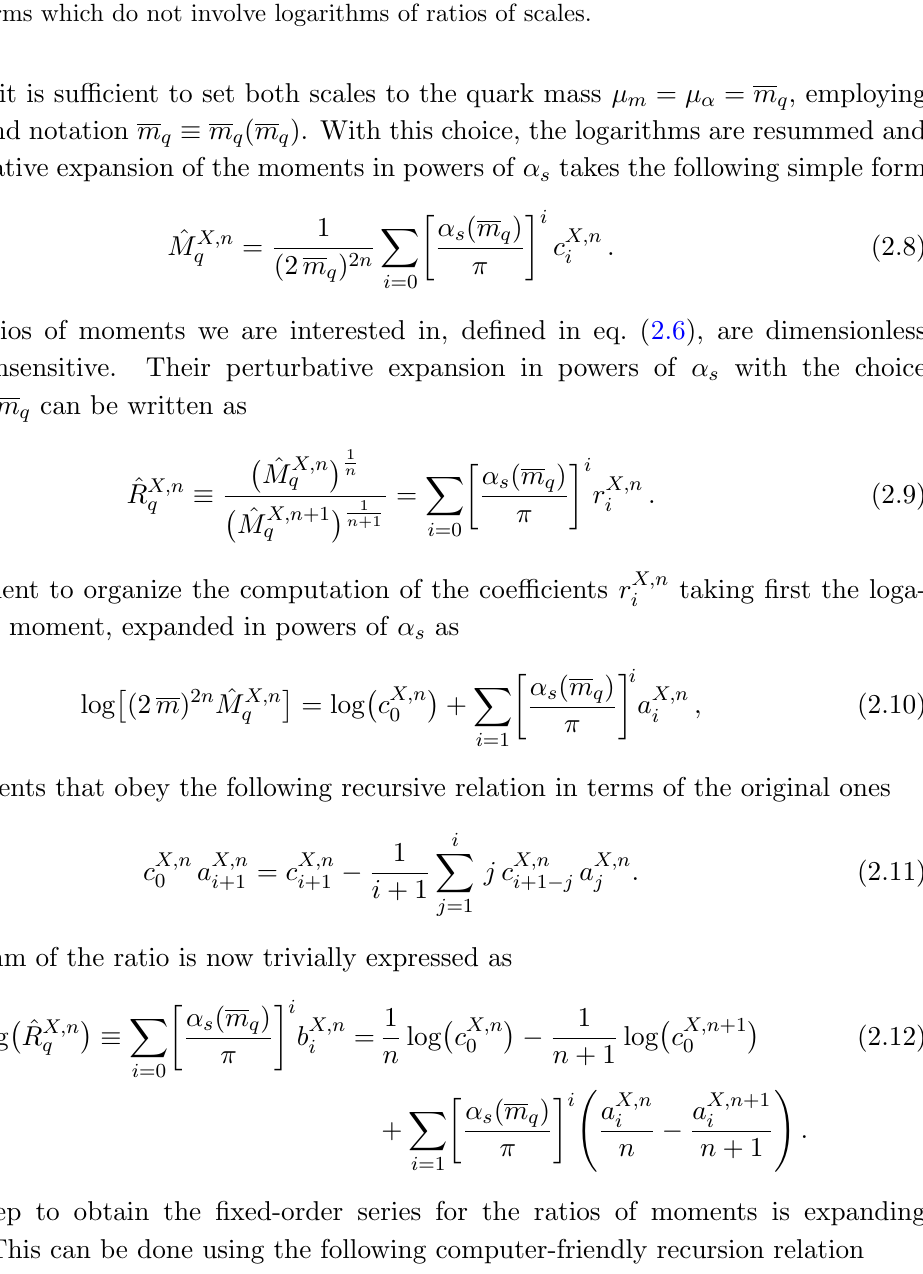
Table 1 . Perturbative coe(cid:14)cients r V;n for the ratios of the charm vector-current correlator. We i show only terms which do not involve logarithms of ratios of